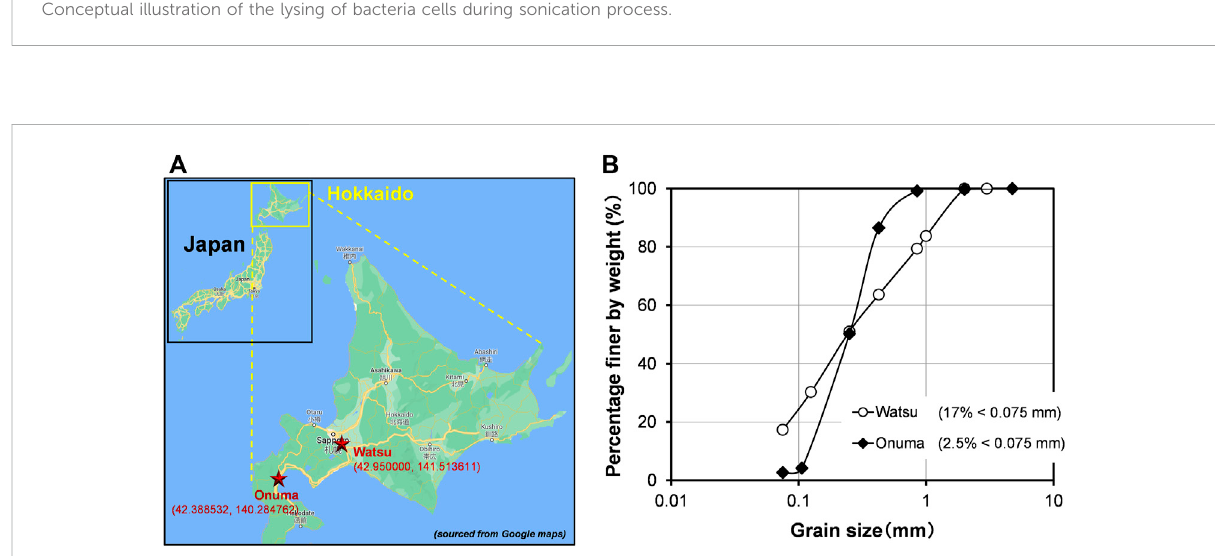
FIGURE 2 (A) Map indicating the sampling locations and coordinates of the expressway slopes and (B) the grain size distribution curves of the slope